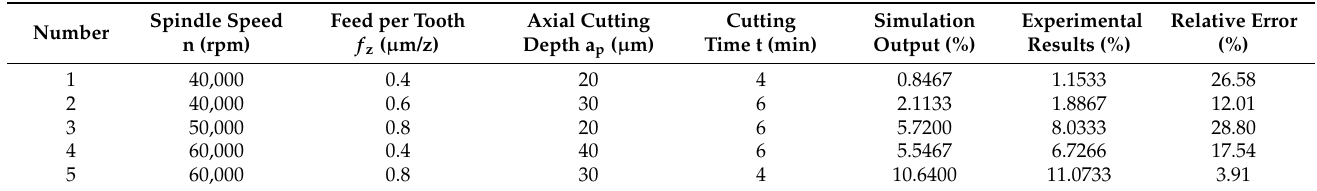
Table 5. The comparison of experimental and simulated reduction rate of the tool